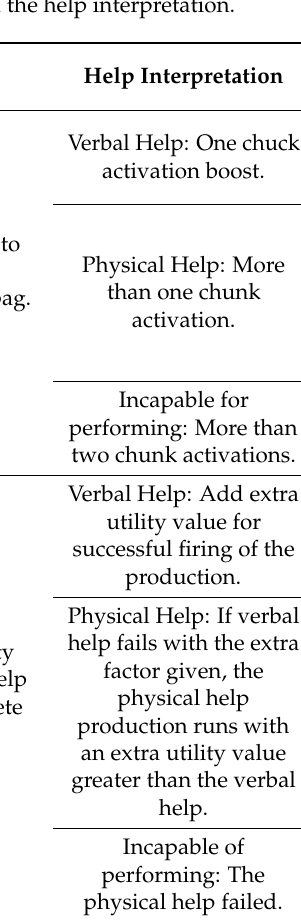
Table 2. Steps of the tea preparation activity with the outcomes and the help